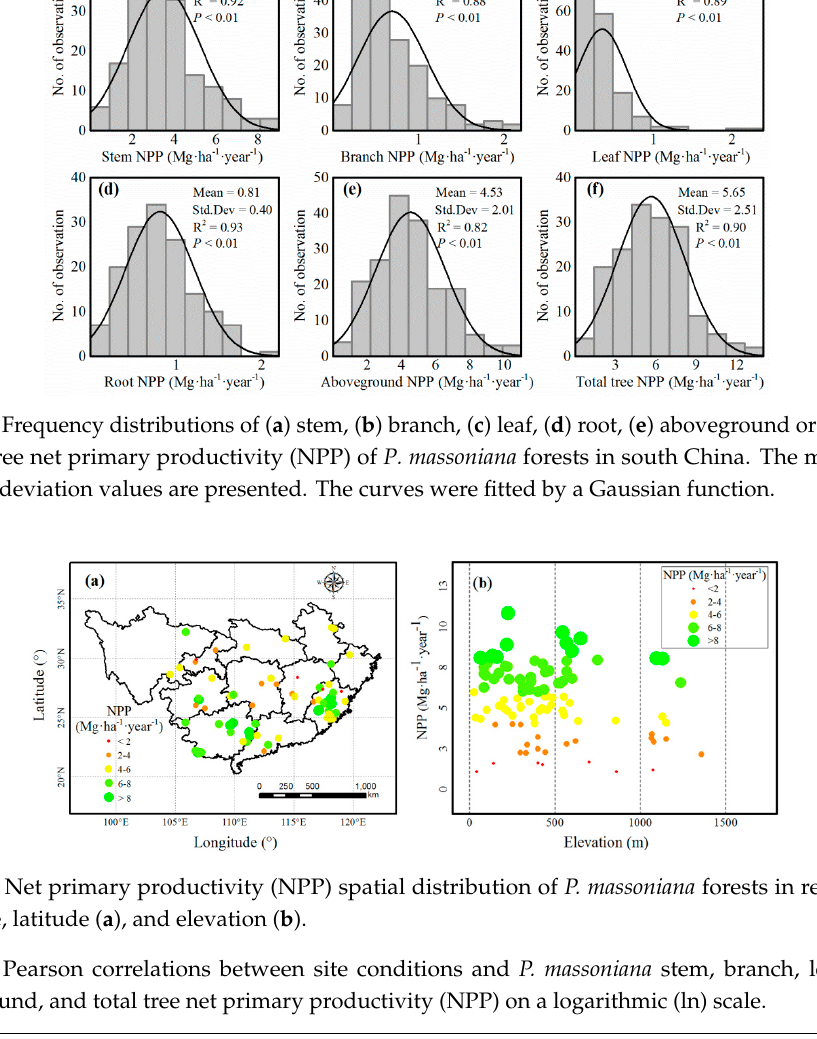
Table 1. Net primary productivity (NPP) of P. massoniana stem, branch, leaf, root, aboveground organs, and total tree. Number of observations (N), mean value (Mean), maximum value (Max), minimum value (Min) and standard error (SE) were reported.